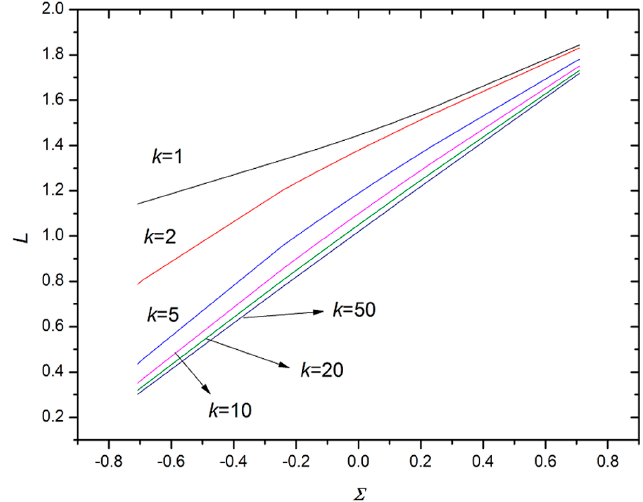
Figure 4. Variation of equilibrium position L ( L = l / R 1 ) with respect to dimensionless interfacial tension Σ ( Σ = ( σ 12 − σ 13 )/ σ 23 ).